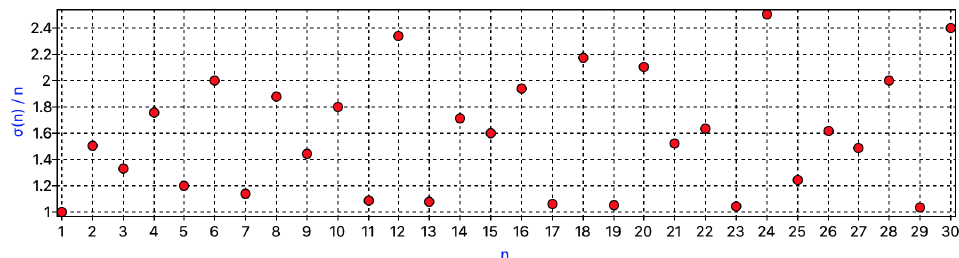
Figure 2. The simulation for σ ( n )